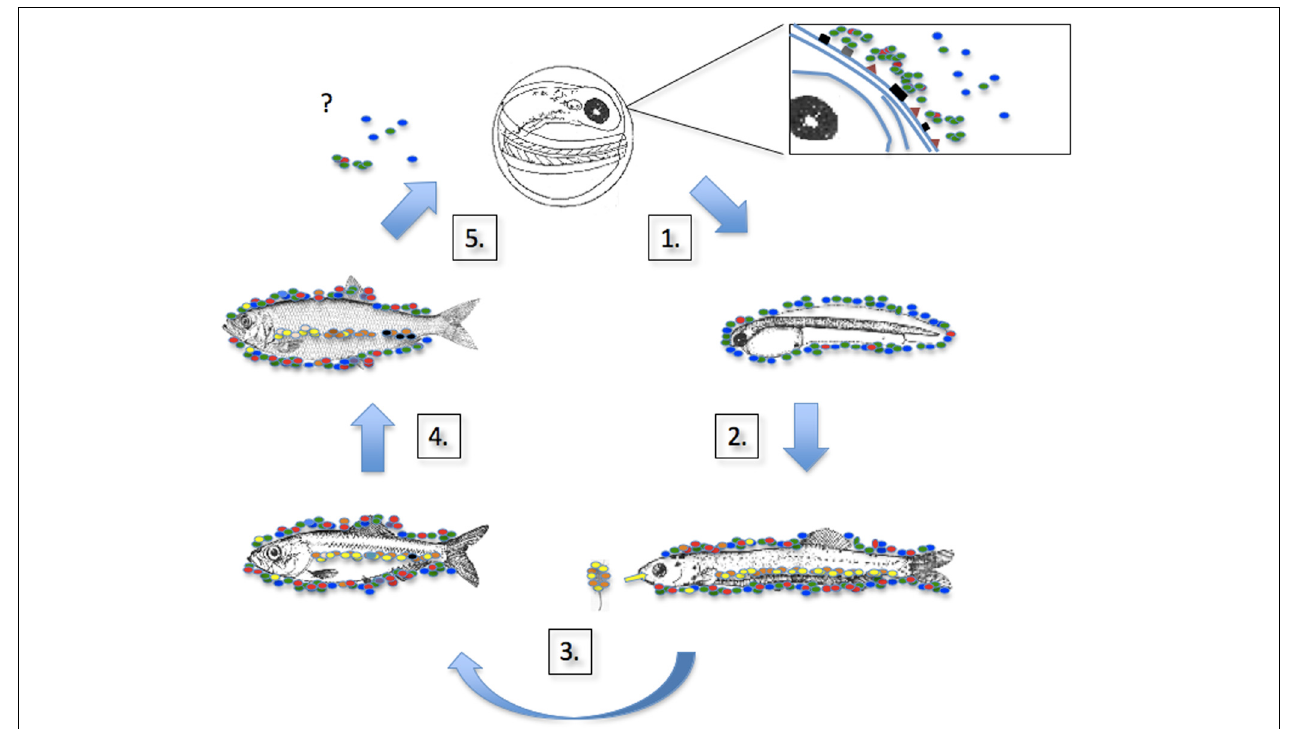
FIGURE 3 | Teleost microbiome during development. Figure shows schematic of the generalized lifecycle of a teleost and accessory indigenous bacteria (different taxa represented by colored elipses). (1) Bacteria colonize the chorion of the egg. Taxonomic differences of bacteria between fish species suggest specific early interactions, perhaps through precursors of innate immunity (symbolized by squares and triangles on the chorion surface). (2) Egg hatches, larval is colonized by environmental bacteria as well as those originally present on the chorion.